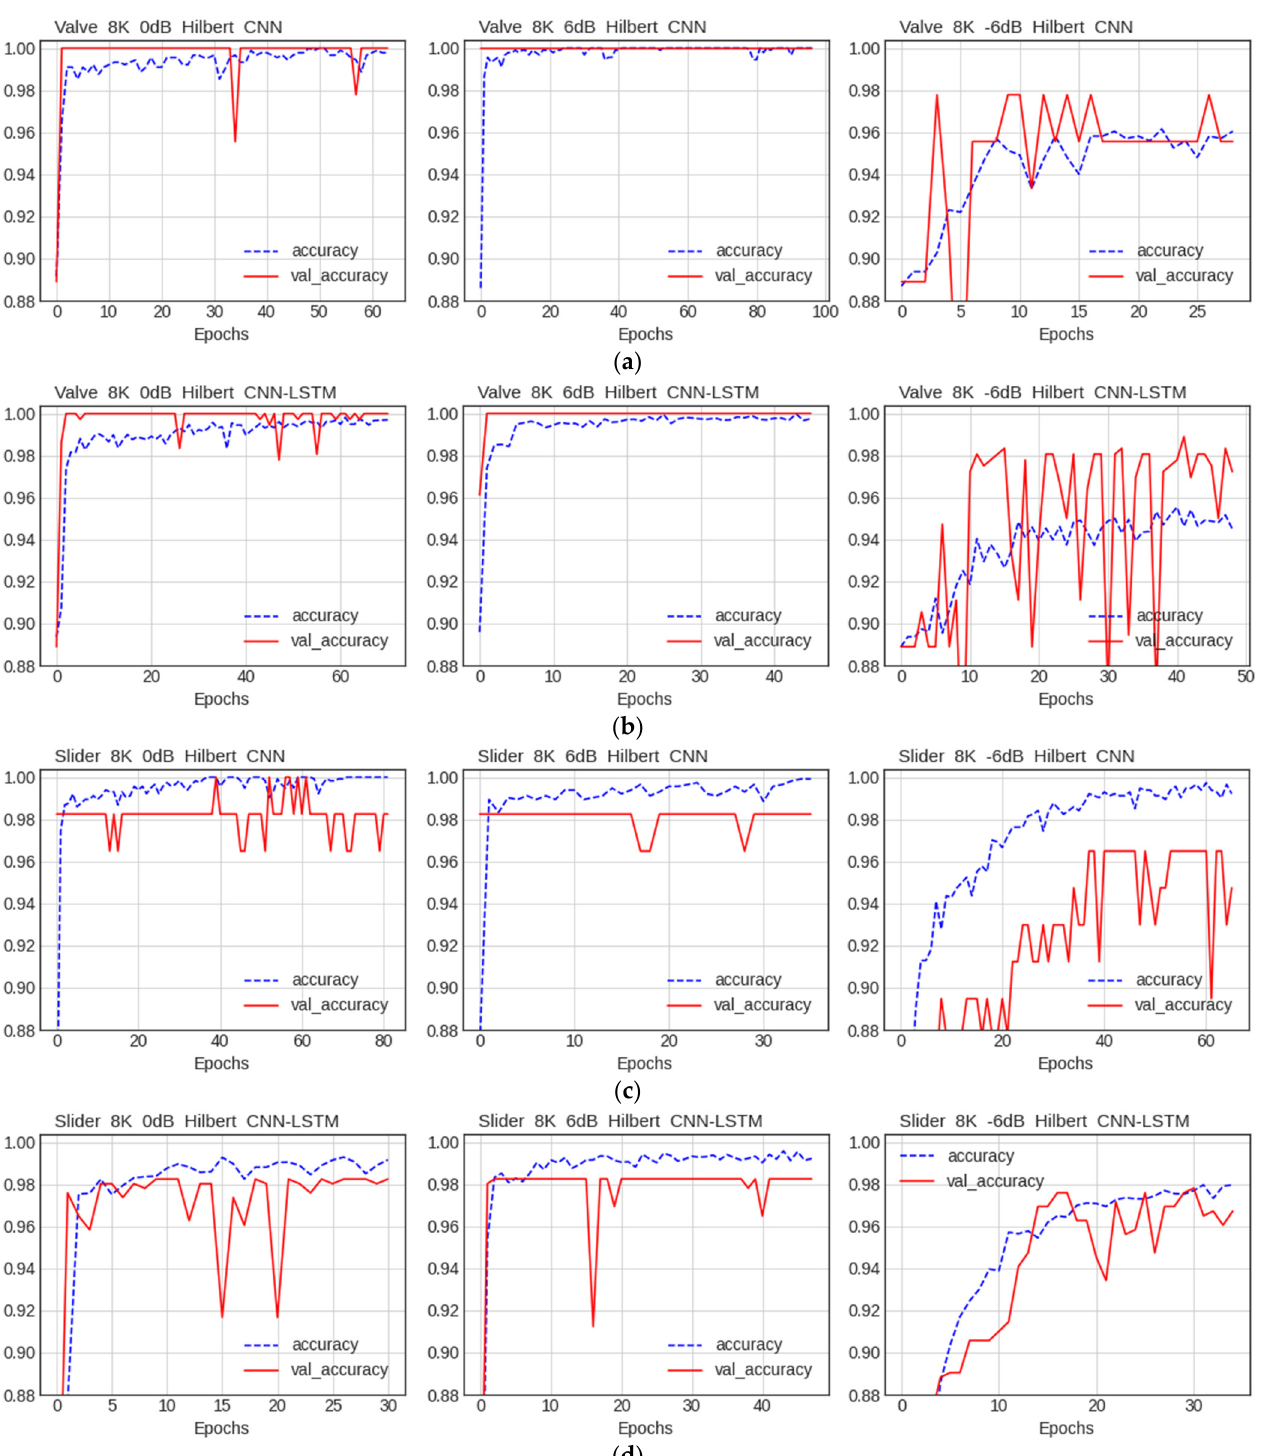
Figure 19. Accuracy of using data after preprocessing with the Hilbert transform (8 K, SNR: 0 dB, 6 dB, − 6 dB): ( a ) results of valve data training on the CNN model; ( b ) results of valve data training on the CNN–LSTM model; ( c ) results of slider data training on the CNN model; and ( d ) results of slider data training on the CNN–LSTM model.